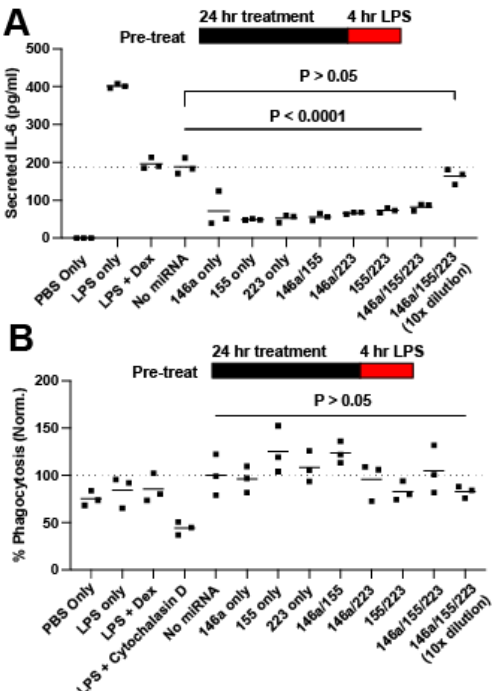
Figure 2. Screening of miRNA for anti-inflammatory combination. ( A ) Secreted IL-6 in response to LPS in a pretreatment regime. ( B ) Phagocytosis as measured by the Vybrant Phagocytosis Assay Kit (Invitrogen).